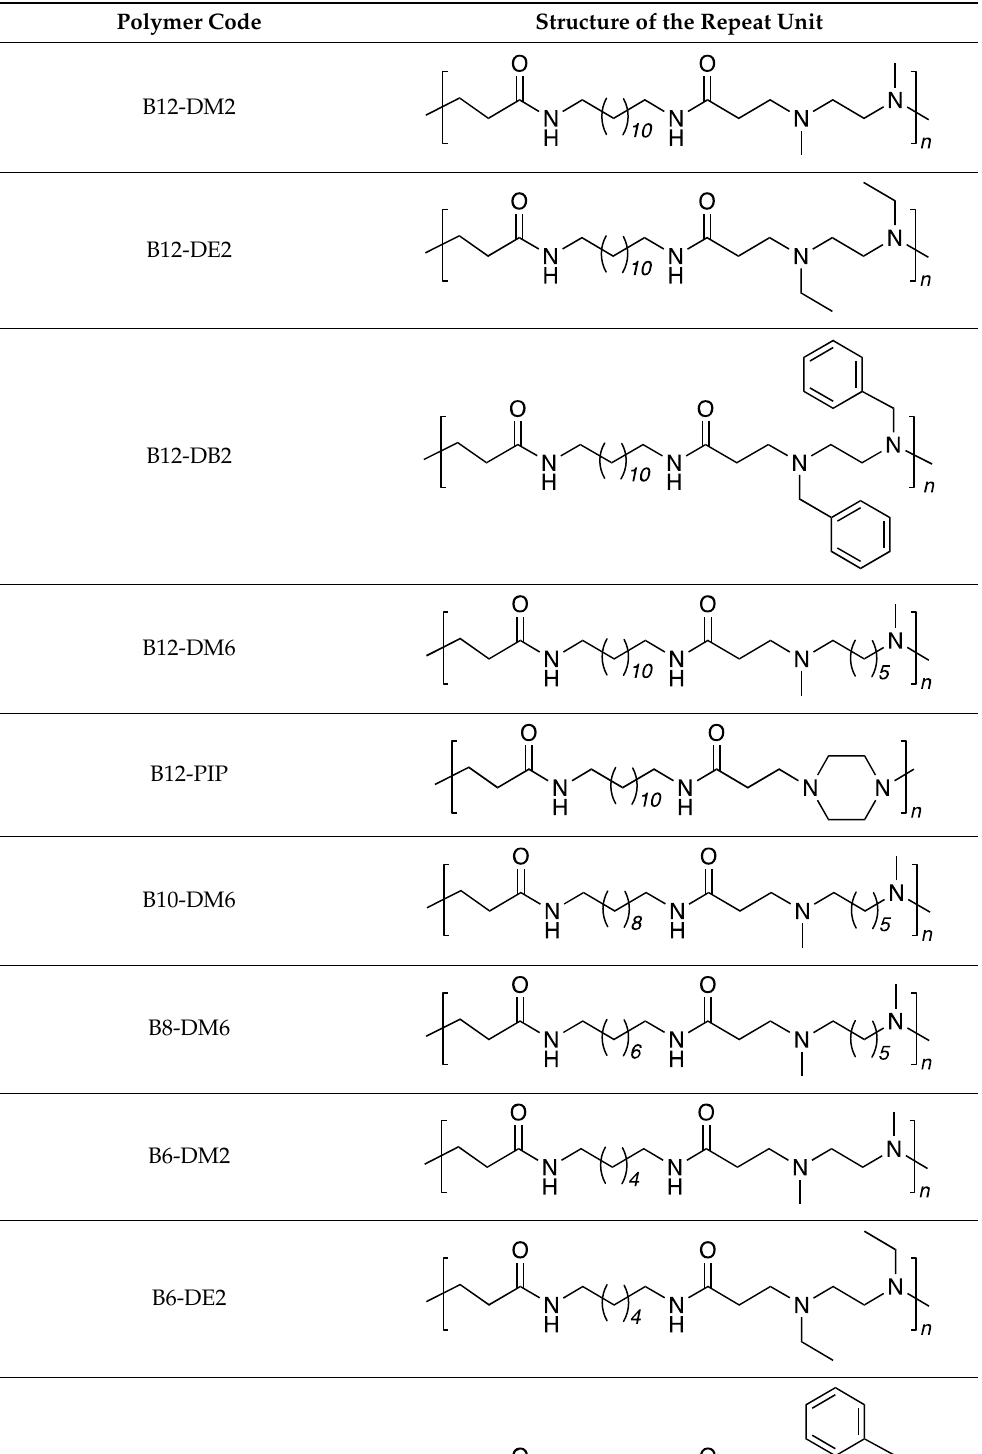
Table 3. Structure of H-PAAs. Table 3 . Structure of H-PAAs. Table 3 . Structure of H-PAAs. Table 3 . Structure of H-PAAs. Table 3 . Structure of H-PAAs. Table 3 . Structure of H-PAAs. Table 3 . Structure of H-PAAs. Table 3 . Structure of H-PAAs. Table 3 . Structure of H-PAAs. Table 3 . Structure of H-PAAs. Table 3 . Structure of